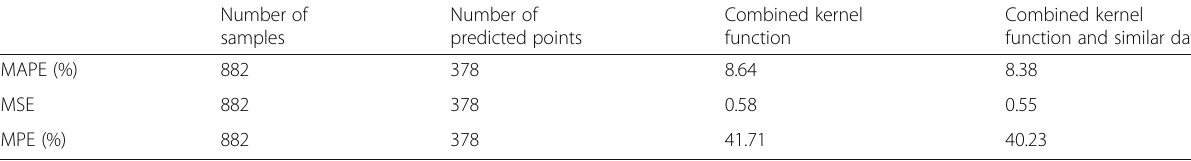
Table 4 A comparison of the prediction results with and without similar data